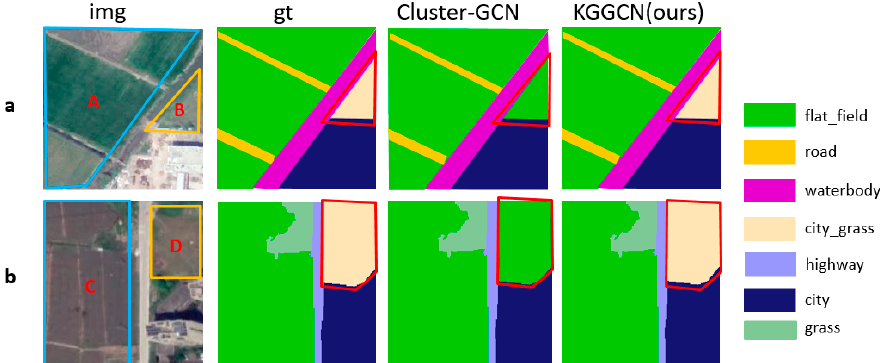
Figure 21. The result of two models in samples with “different objects with the same spectrum”. In ( a ), city_grass (B) is misclassified as flat_field in Cluster-GCN and classified correctly in KGGCN. In ( b ), city_grass (D) is misclassified as flat_field in Cluster-GCN and classified correctly in KGGCN. The other is samples with “scene distortion”. Some geo-objects in these samples are clipped improperly. Samples are demonstrated in Figure